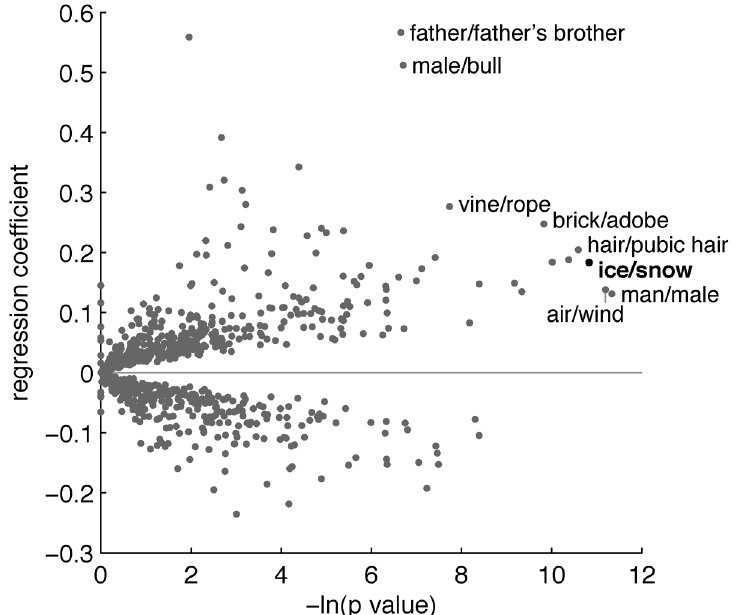
Fig 6. Regression coefficients and -ln( p ) values for the exhaustive analysis of meaning pairs in the IDS+ dataset. Labels are included for all non-dominated pairs that are associated with a positive regression coefficient. Two of these pairs include “ male, ” which is a meaning associated with animals rather than